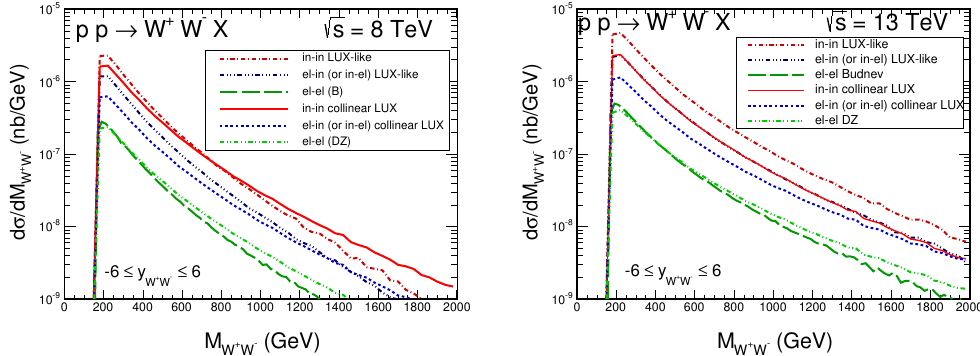
Figure 7 . The inelastic-inelastic, elastic-inelastic, inelastic-elastic and elastic-elastic contributions to W + W (cid:0) invariant mass distributions for the k T -factorization approach with the LUX-like struc- ture function compared to the relevant distribution for collinear approach with similar structure function LUXqed. The left panel shows results for p for s = 13